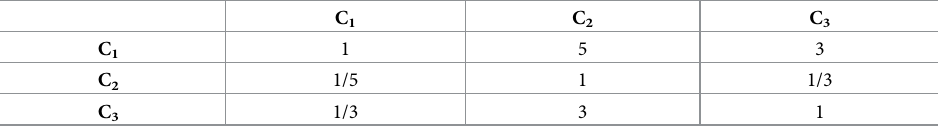
Table 13. Pair-wise comparisons of the first level factors in the emergency response 1.